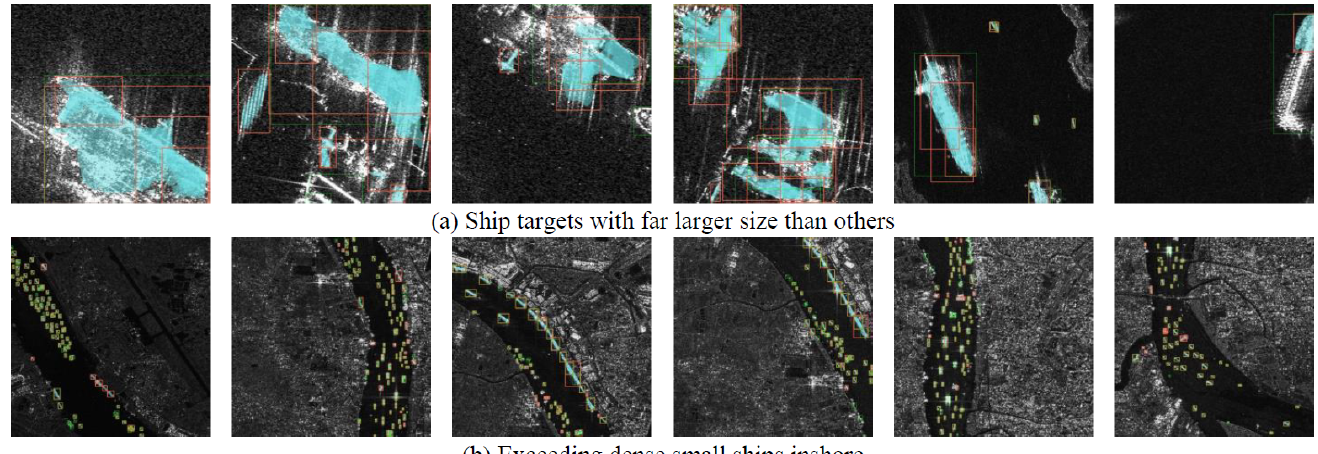
Figure 8. Visible ship instance segmentation results of our SA R-CNN from the test set of HRSID in some difficult situations where the effect was not good enough in these hard samples: ( a ) for some ship targets in a large proportion of the image, only part of the target can be detected but the whole has been cut off; and ( b ) for some excessively dense small inshore ships, our method cannot avoid missing some and making false